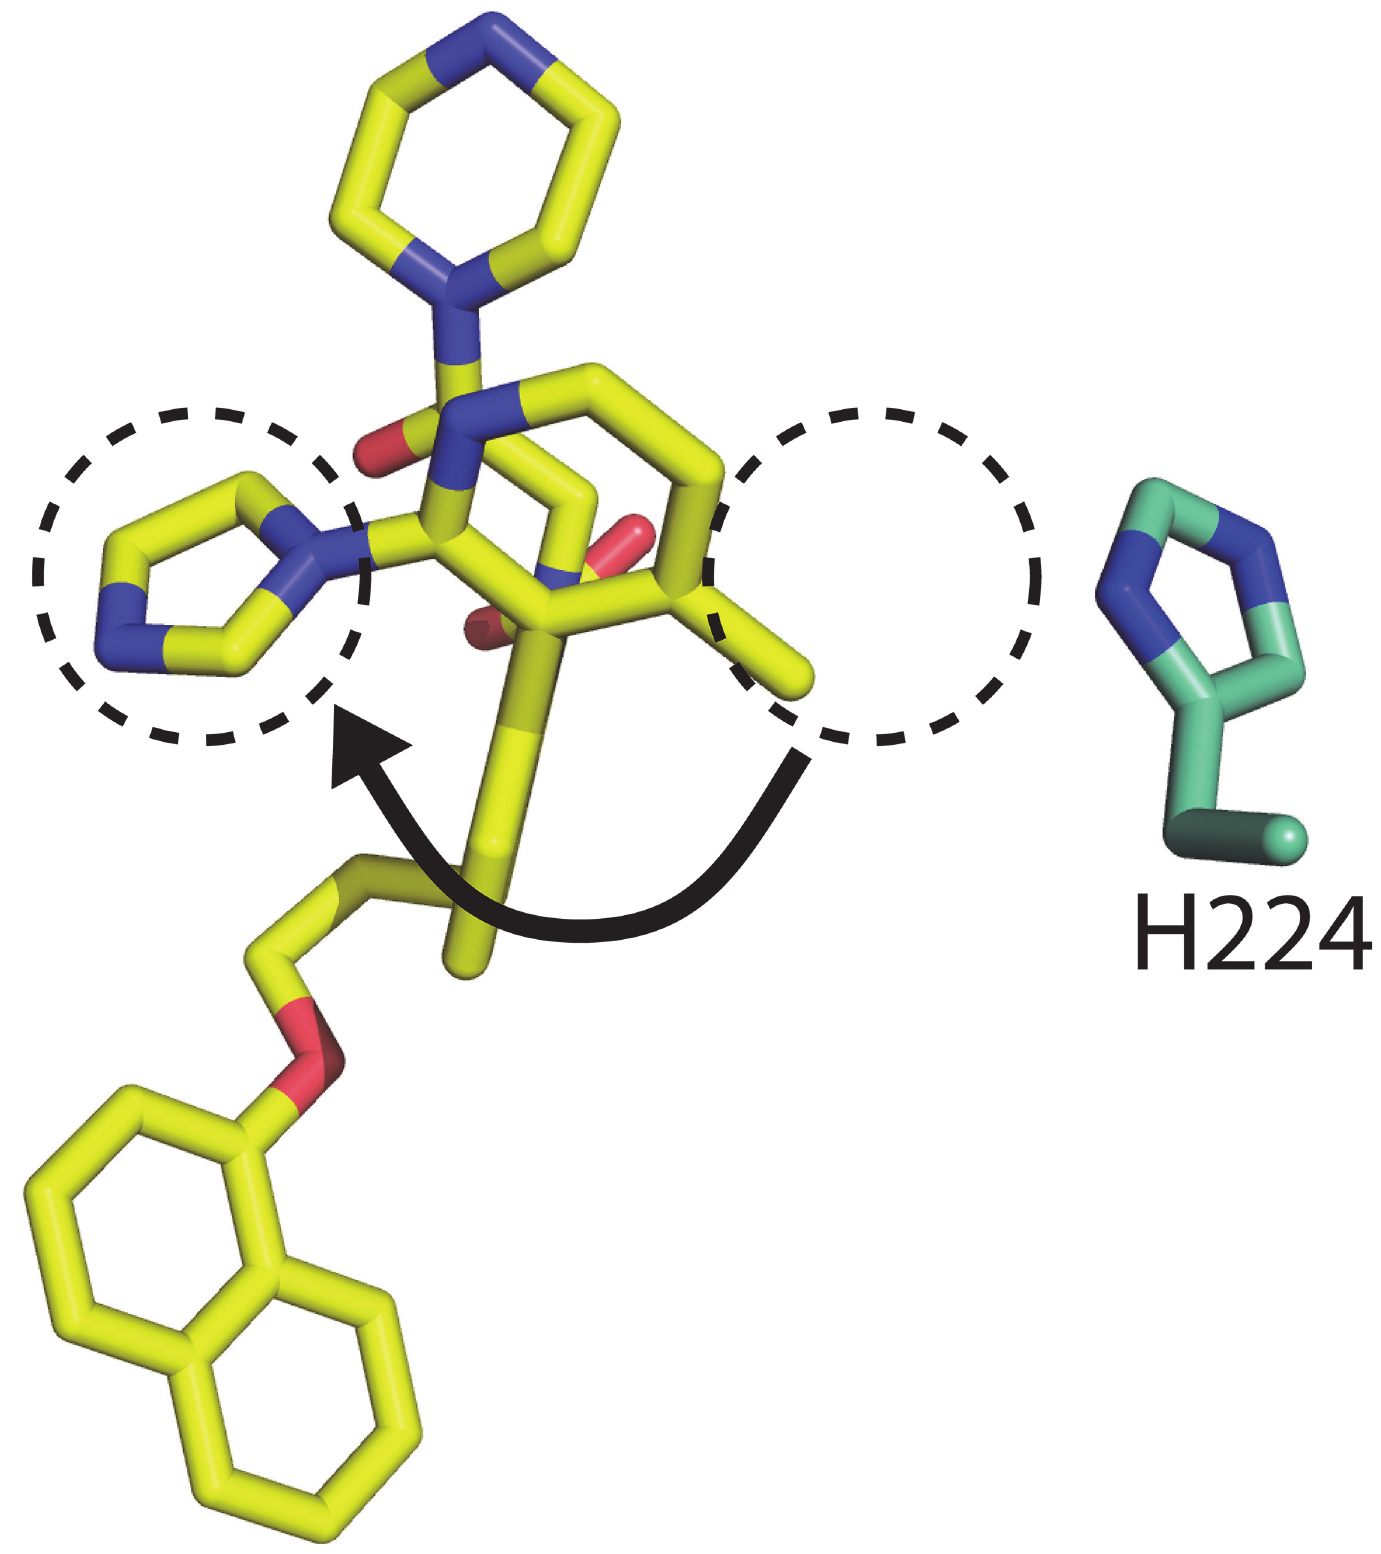
Fig 4. Removal of crystal packing interactions allows sidechain rotation of ligand 1. In the absence of zinc and pyrophosphate, the pyridine ring of 1 rotates 180° away from H224 allowing the imidazole to face out towards the solvent channel. doi:10.1371/journal.pone.0125010.g004 PLOS ONE | DOI:10.1371/journal.pone.0125010 April 24,